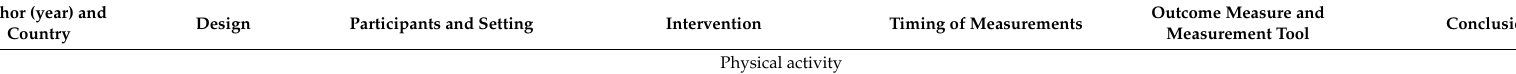
Table 1. Overview of the included experimental